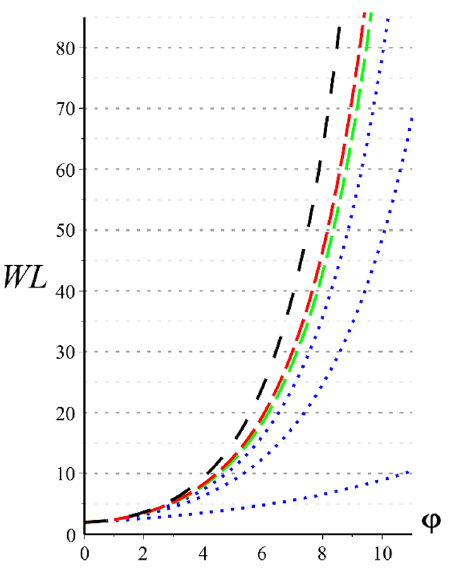
JHEP04(2021)053